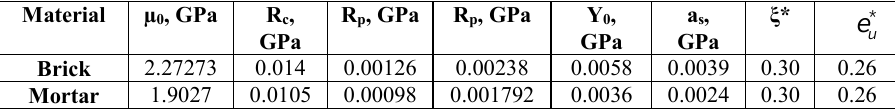
Table 2. The physical and mechanical properties of the brick M100.